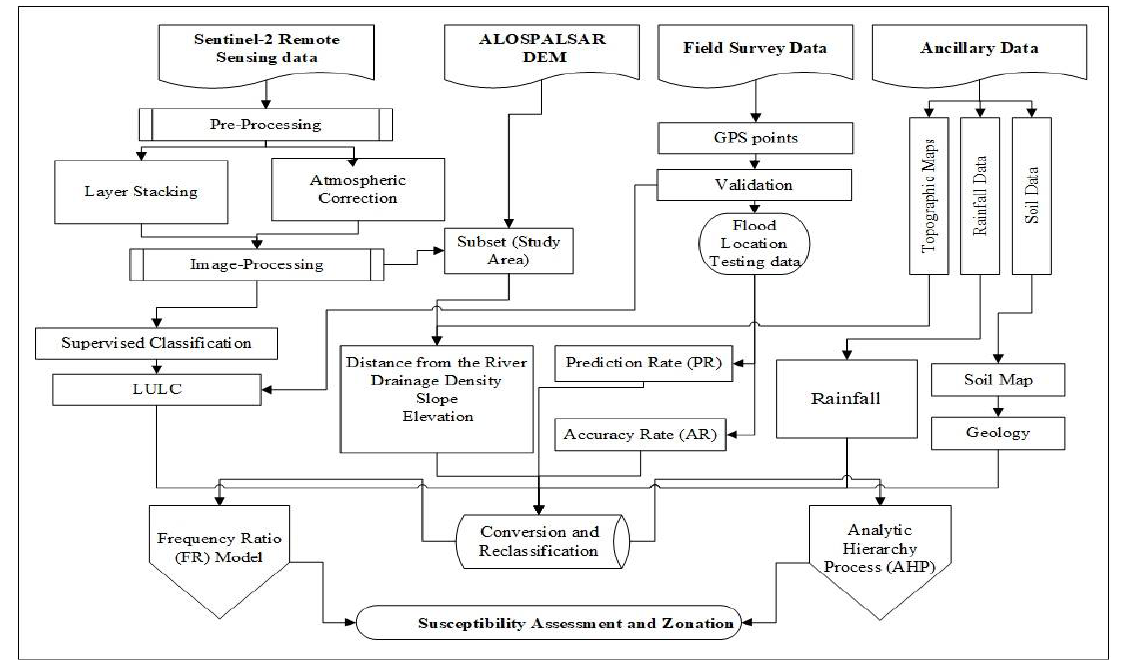
Figure 4. Flow chart of the methodology used in this study.